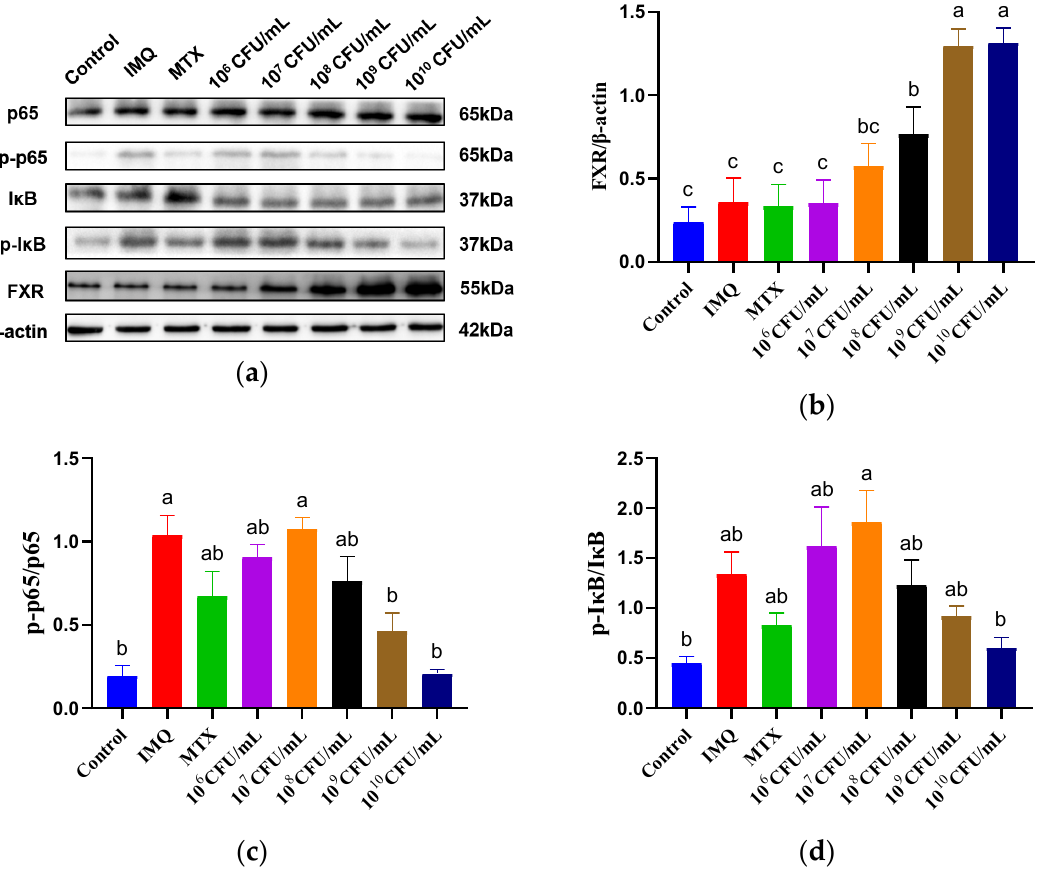
Figure 7. Effect of CCFM683 treatment on the FXR /NF- κ B pathway in psoriasis mice. ( a – d ) Quantitative analysis of the key proteins in FXR/NF- κ B pathway in IMQ-treated mice by Western blotting. n = 3 mice per group. Groups with different letters are significantly ( p < 0.05) different from each other.